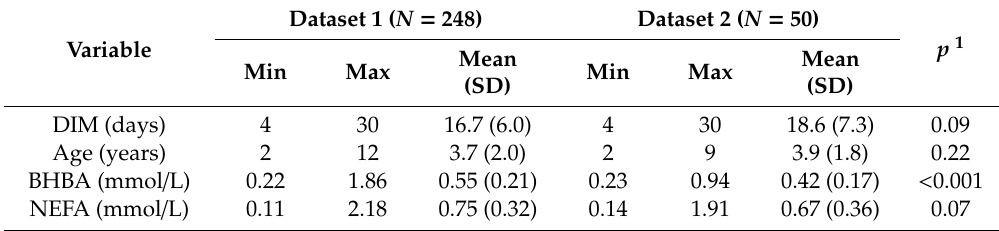
Table 1. Descriptive statistics of the datasets used in this experiment, including number of animals (N), stage of lactation defined as days in milk (DIM), age in years, and β -hydroxybutyrate (BHBA) and non-esterified fatty acid (NEFA) concentrations (mmol / L) in the serum obtained from clinically healthy dairy